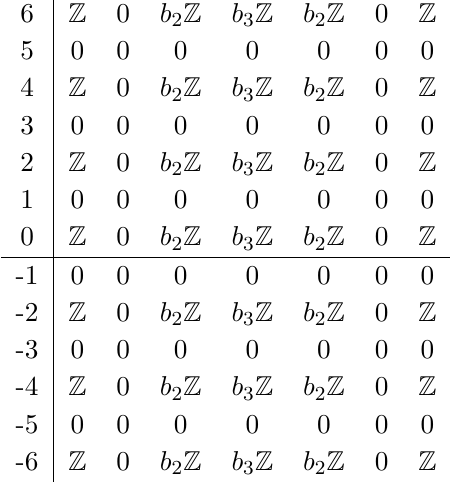
Table 17 . Second (and final) page of AHSS for computation of K − n ( CY 3 )